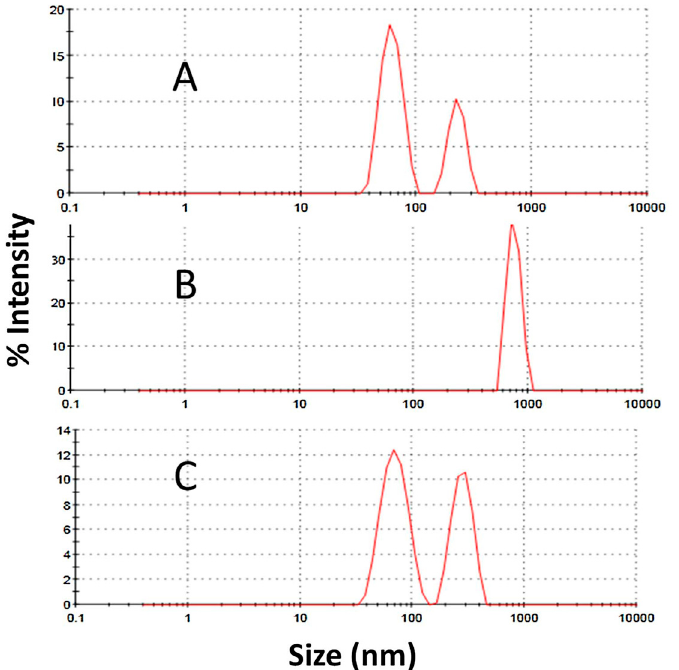
Figure 17. Dynamic light scattering (DLS) analyses for a desorbed quadrivalent human papillo- mavirus virus-like particles (HPV VLP) vaccine at different pH values: ( A ) at pH 6.2, ( B ) at pH 4.0, ( C ) at pH 8.0. Data are shown as intensity size distribution. Aggregate formation by forced degra- dation conditions can be observed in Figures ( B , C ), pH 4.0 and 8.0, respectively. Reproduced with permission from [187], Elsevier, 2017.